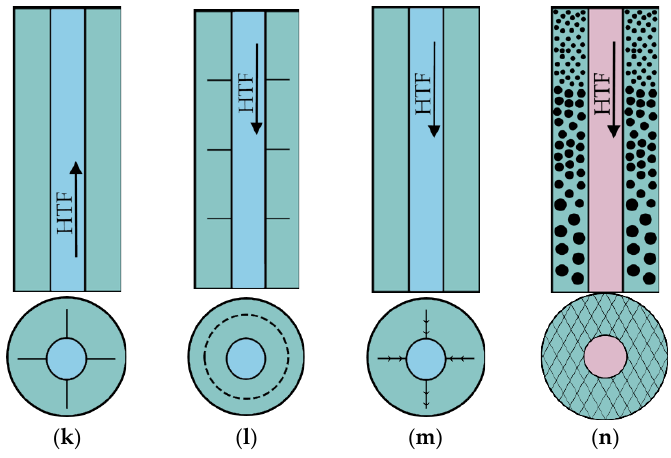
Figure 2. Vertical double-tube arrangements; ( a ) Case DTV-B-M; ( b ) Case DTV-T-M; ( c ) Case DTV-B-ILF-M; ( d ) Case DTV-B-SC-M; ( e ) Case DTV-T-CF-M; ( f ) Case DTV-B-FR-MP-M; ( g ) Case DTV-B-